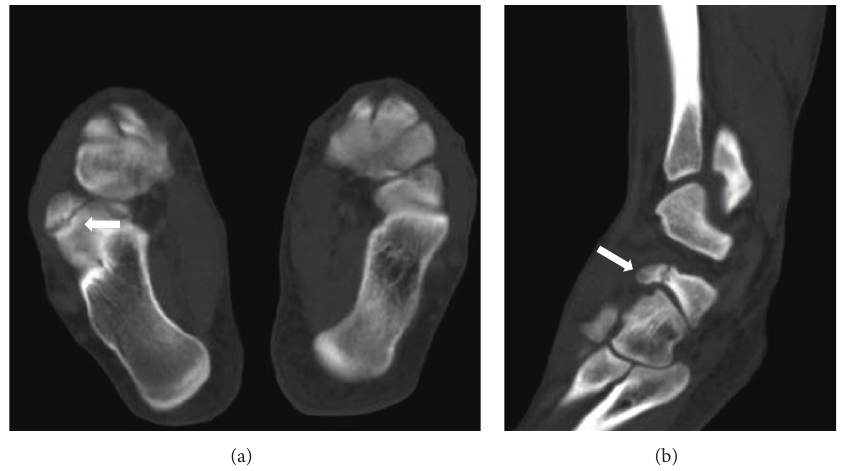
Figure 2: Axial (a) and sagittal (b) reformatted CT images reveal os calcaneus secundarius (white arrows).